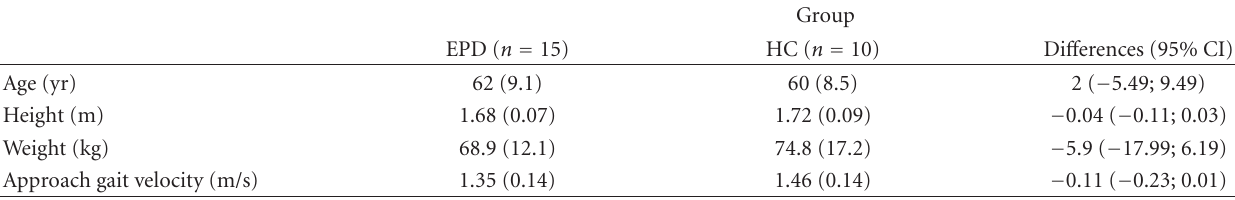
Table 1: Mean and standard deviation of participant’s